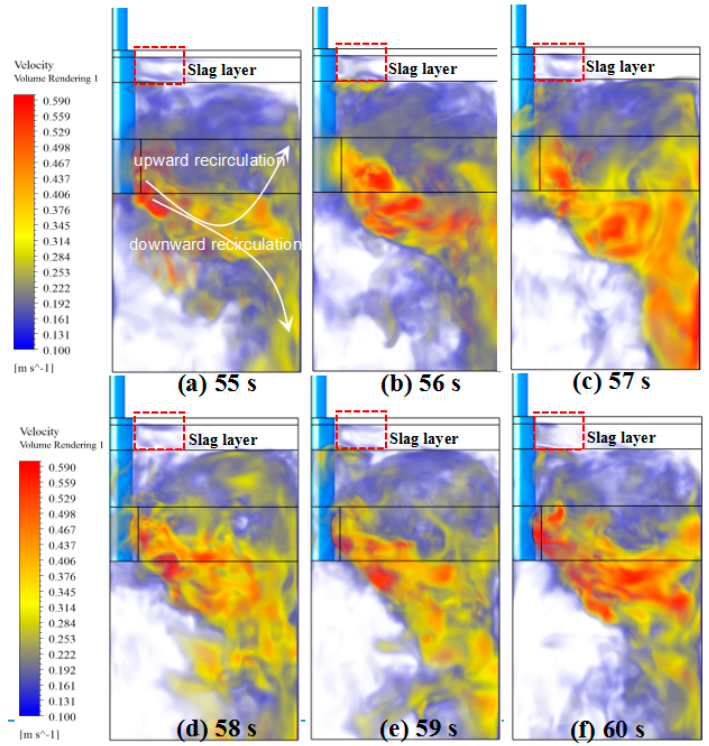
Figure 6. The instantaneous flow field after ( a ) 55 s, ( b ) 56 s, ( c ) 57 s, ( d ) 58 s, ( e ) 59 s, and ( f ) 60 s.